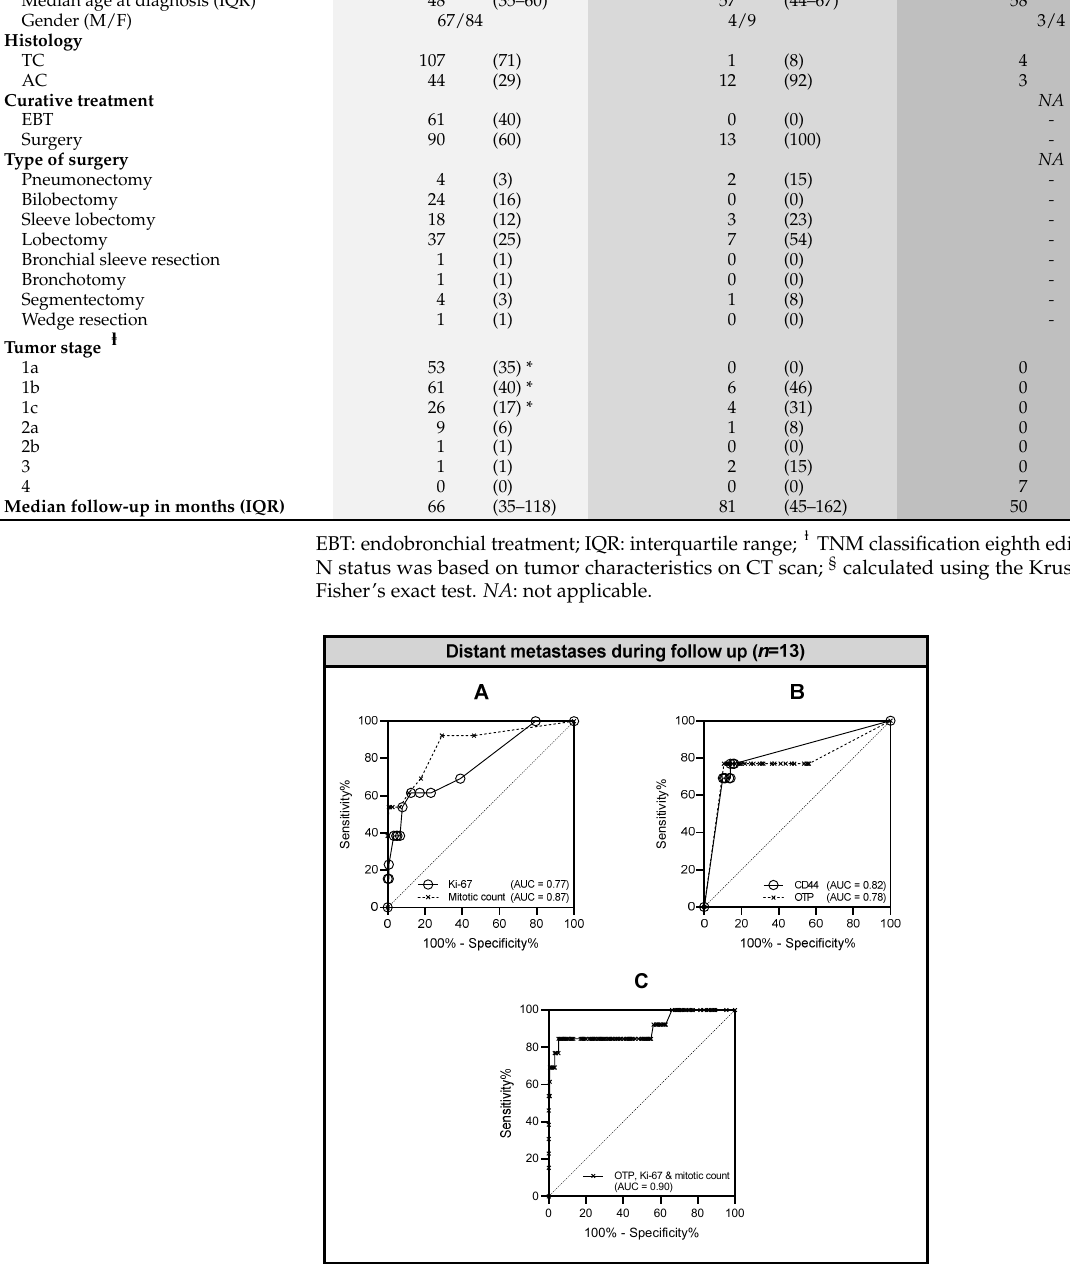
Table 1. Clinicopathological characteristics of patients treated for bronchial carcinoid ( n = 171).